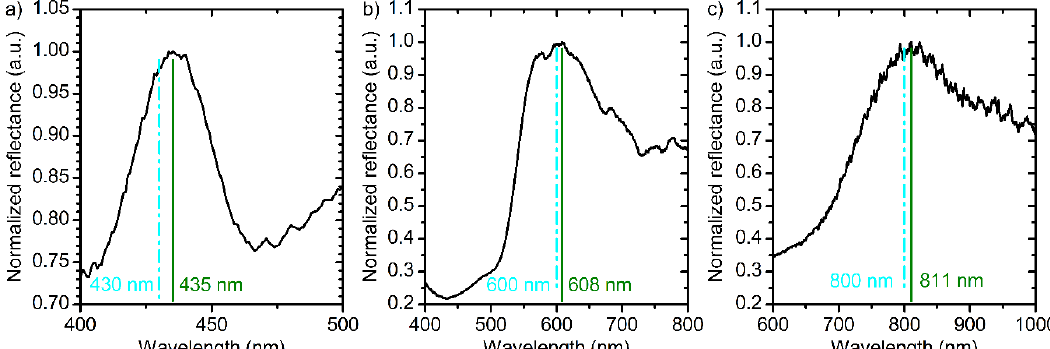
Figure 7. Reflectance spectra at normal incidence of light of PC_5 ( a ), PC_6 ( b ), and PC_7 ( c ) prepared by the suggested technique using Equations (7) and (8) for the OPL calculation. The assigned positions of photonic band gap are 430 ( a ), 600 ( b ), and 800 nm ( c ). Cyan dash lines and green solid lines show the assigned and the measured photonic band gap positions. Parameters of the synthesis: ( a ) t 0 = 50 min; L total = 10750 nm; L 0 = 215 nm; ( b ) t 0 = 60 min; L total = 15000 nm; L 0 = 300 nm; ( c ) t 0 = 70 min; L total = 16000 nm; L 0 = 400 nm.